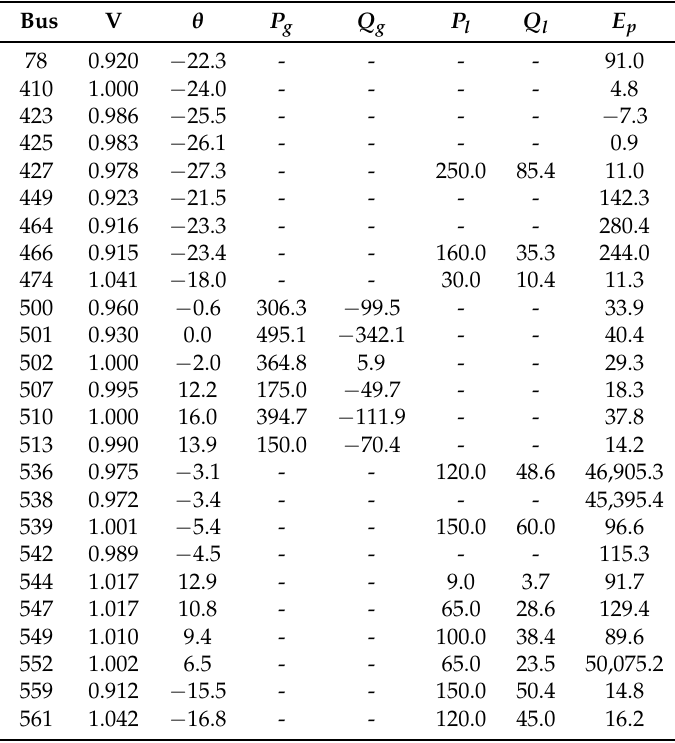
Table A1. Base case power flow and the Robustness Area (RA)